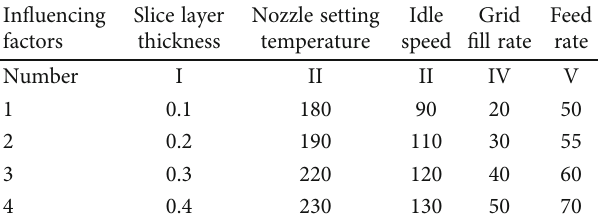
Table 3: In fl uencing factors and distribution.